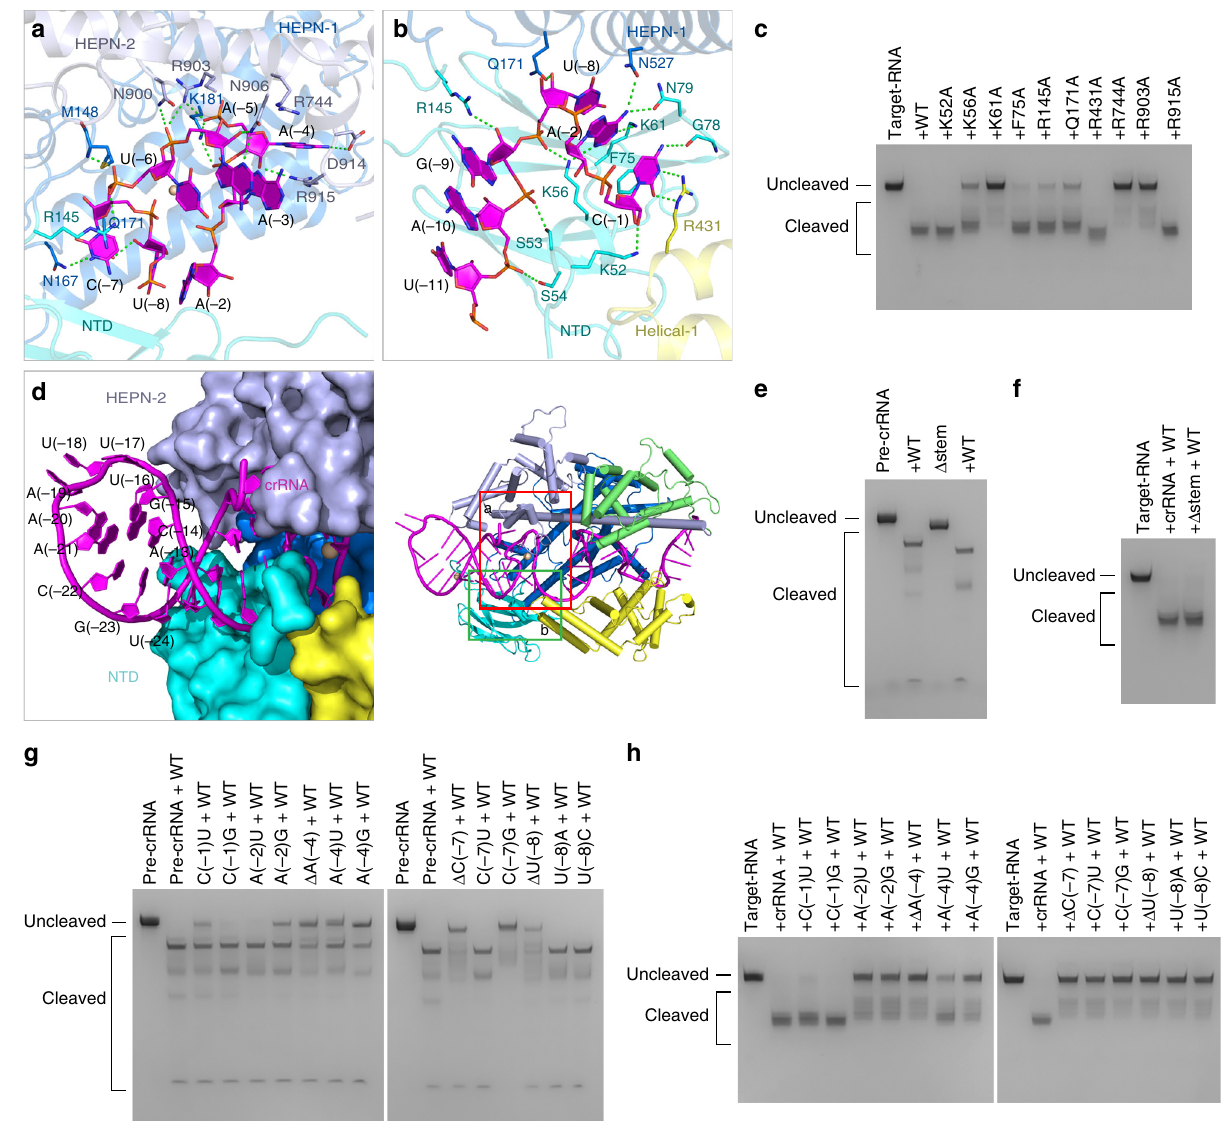
Fig. 4 Structure-speci fi c and sequence-speci fi c recognition of the crRNA repeat region. a and b Details of the interactions between the crRNA repeat region and UrCas13d. c Denaturing gel demonstrating the cleavage of target RNA by wild-type UrCas13d and the mutants in complex with crRNA. d The crRNA repeat region is bound inside the channel formed by NTD, HEPN-1, and HEPN-2 domains of UrCas13d. The nucleotides U(-24)-A(-13) of the crRNA repeat region protrude from UrCas13d. e Denaturing gel demonstrating the cleavage of pre-crRNA or the Δ stem mutant (the deletion of the nucleotides U(-24)-A (-21)/U(-16)-A(-13) in pre-crRNA) by wild-type UrCas13d. f Denaturing gel demonstrating the cleavage of target RNA by wild-type UrCas13d in complex with crRNA or the Δ stem mutant (the deletion of the nucleotides U(-24)-A(-21)/U(-16)-A(-13) in crRNA). g Denaturing gel demonstrating the cleavage of pre-crRNA or the pre-crRNA mutants by wild-type UrCas13d. h Denaturing gel demonstrating the cleavage of target RNA by wild-type UrCas13d in complex with crRNA or the crRNA